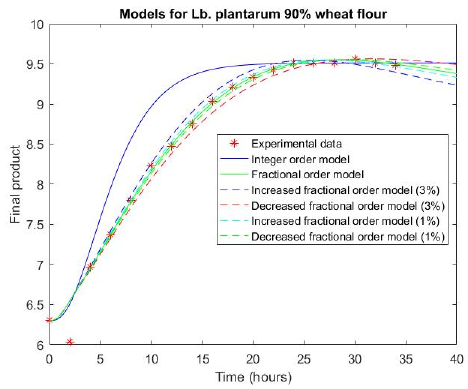
Figure 3. Comparison between simulated and experimental data for experiment 3 using L. plantarum .